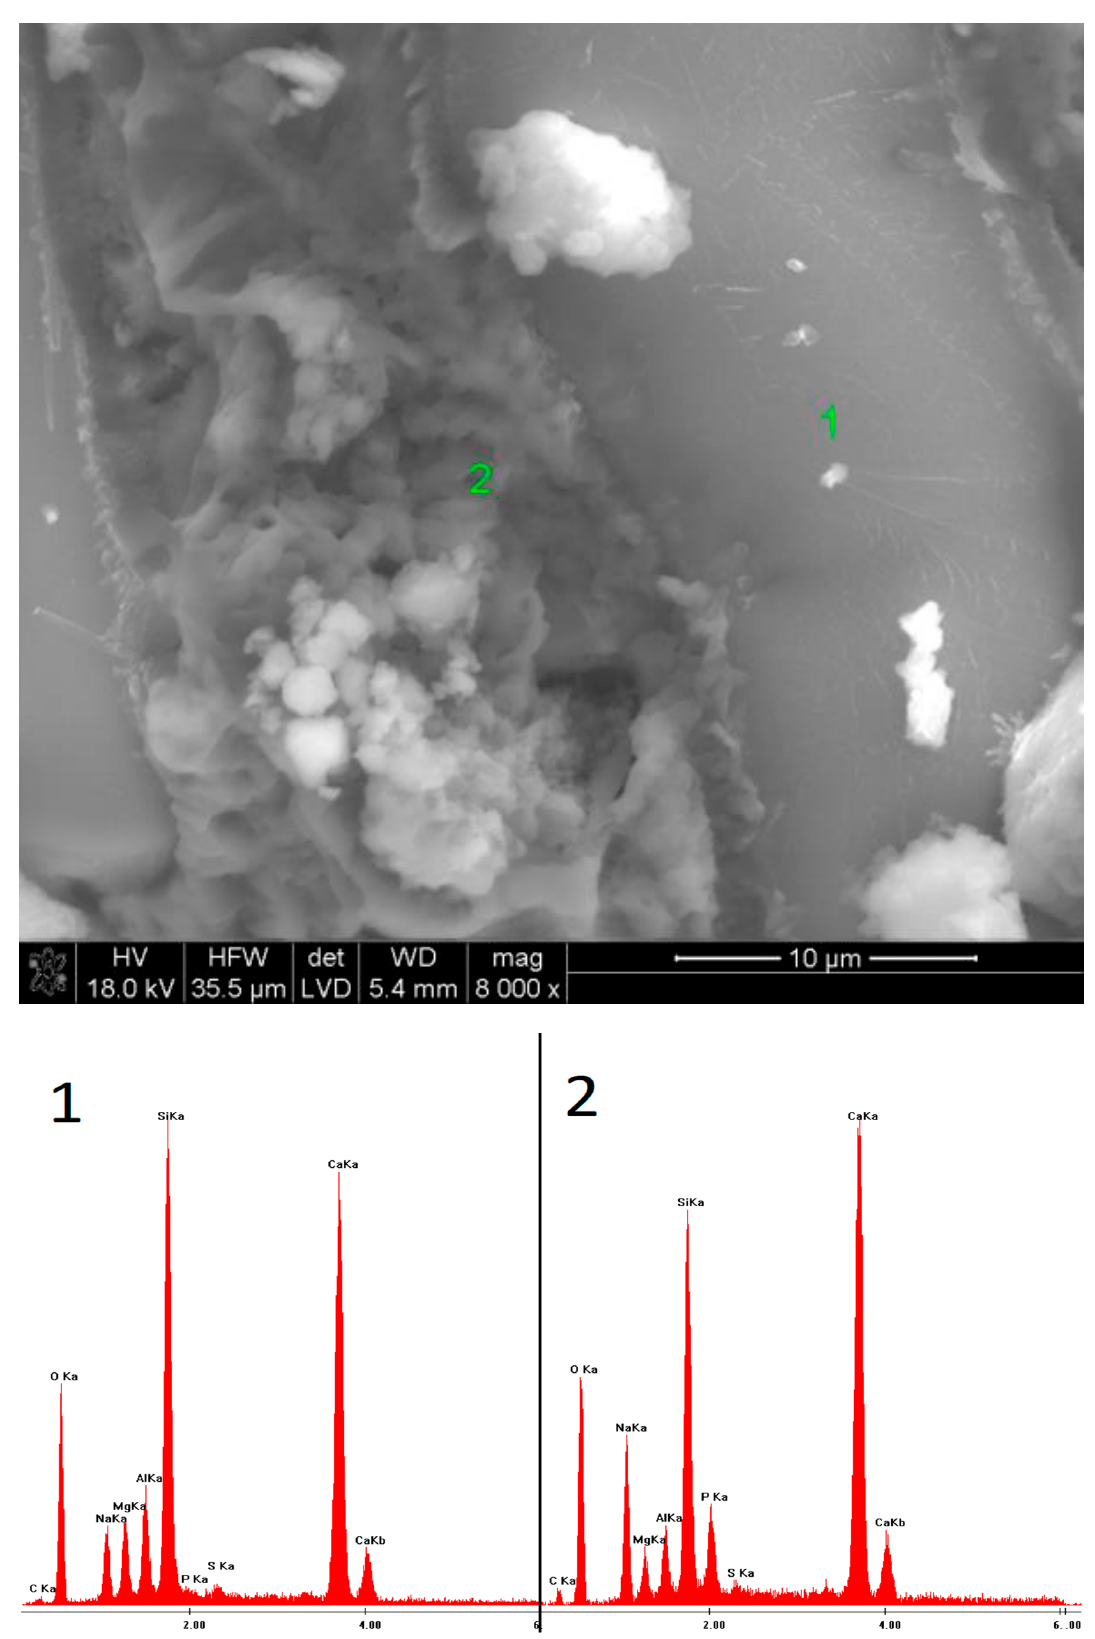
Figure 13. Microstructure of slag paste activated with sodium hypophosphite after 40 days of curing—SEM + EDS; 1 —unreacted slag grain; 2 —hydration products.